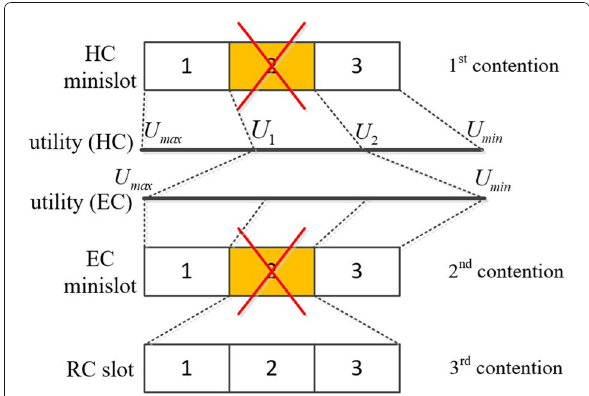
Fig. 4 Example of mapping between utility values and minislots